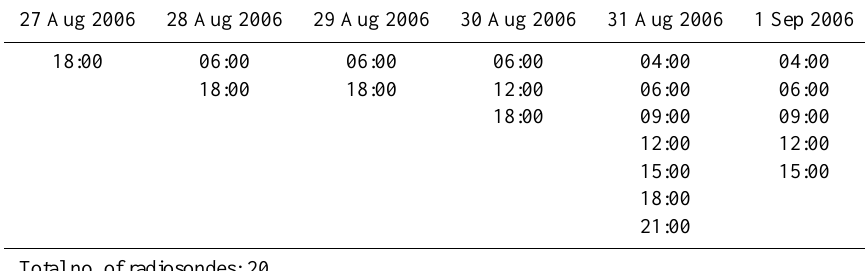
Table 3. Noah LSM parameters used for the UH-CC site in the MM5 and WRF simulations. Parameter Meaning Value Category LU_INDEX IVGTYP Land use index vegetation type 2 Dryland cropland and pasture ISLTYPE Soil type Clay VEGFRAC Vegetation fraction 55.20 Green vegetation fraction